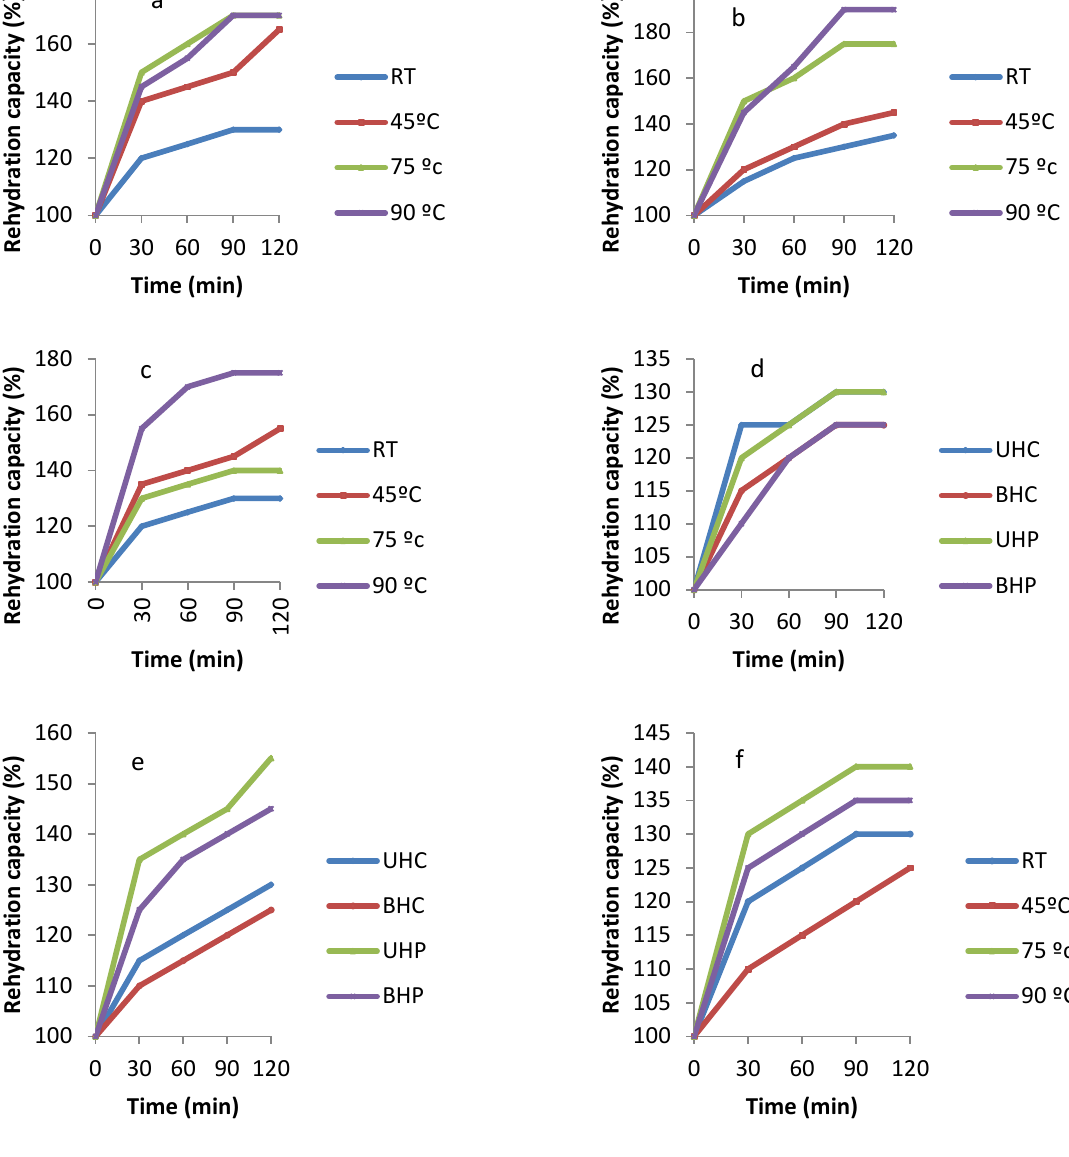
Figure6: Rehydration capacity of: Figure 7: Rehydration capacity of: a. Unblanched plantain sun-dried; b. Unblanched plantain dried at 50°C; c. Unblanched plantain dried at 70°C; d. Cardaba and plantain slices dried at 70°C and rehydrated at room temperature; e. Cardaba and plantain slices dried at 70°C and rehydrated at 45°C; f. Blanched cardaba banana dried at